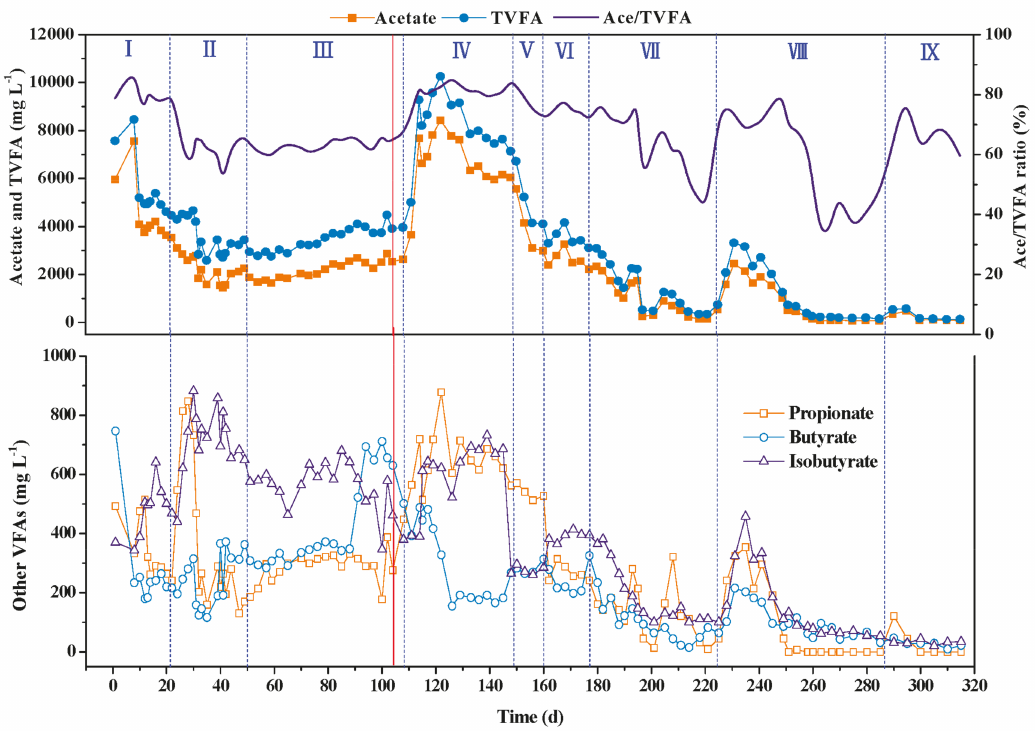
Figure 2. Concentrations of VFAs in the supernatant of anaerobic digestion. Ace =